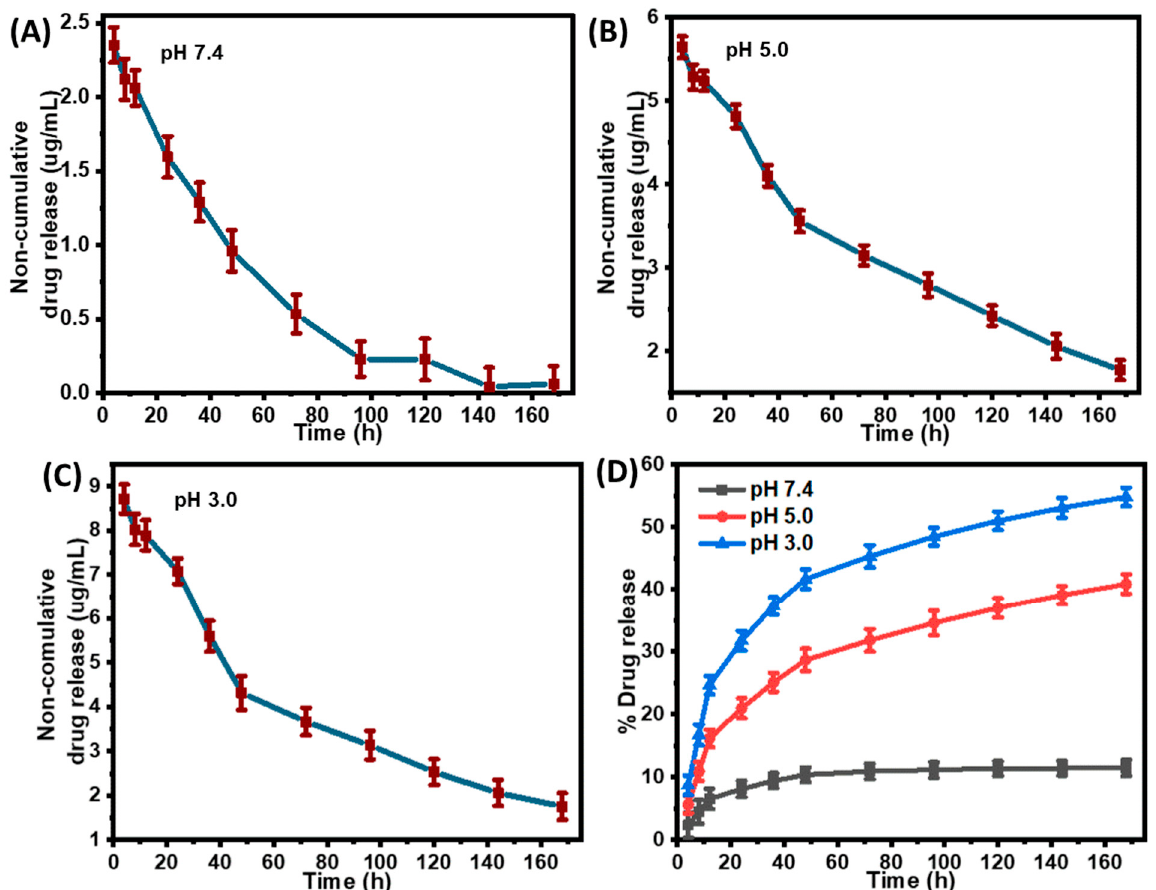
Figure 1. ( A – C ) are representing non-cumulative gentamicin release at pH 7.4, 5 and 3, respectively; and ( D ) is representing cumulative percent release of gentamicin at all pH conditions from G-PDA 1:1. Data were mean ± SD ( n = 3).